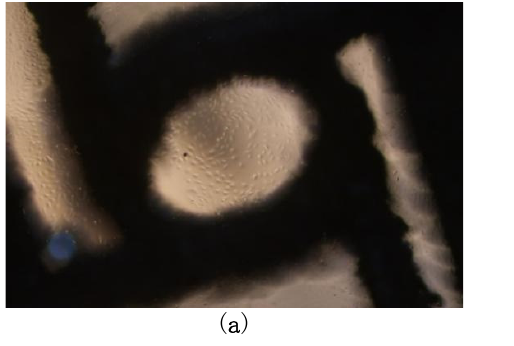
Figure 9. Cytotoxic experiments indicating cellular viability of HUVECs treated with liquid extracts of the LPBF-manufactured scaffolds, polyethylene, and polyurethane at 24, 48, and 72 h. The viabil- ities of the LPBF-manufactured scaffolds and polyethylene group were higher than 95%, and that of polyurethane was lower than 49%.